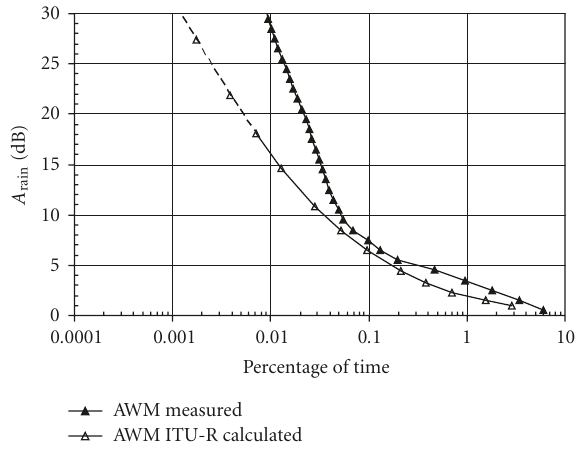
Figure 7: CDs of rain attenuation for AWM.